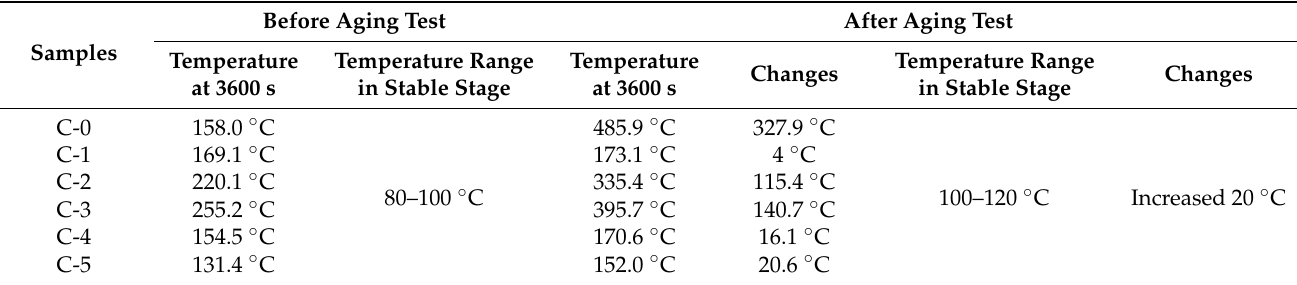
Table 2. Backside temperature values of the hydrogels before and after aging test.